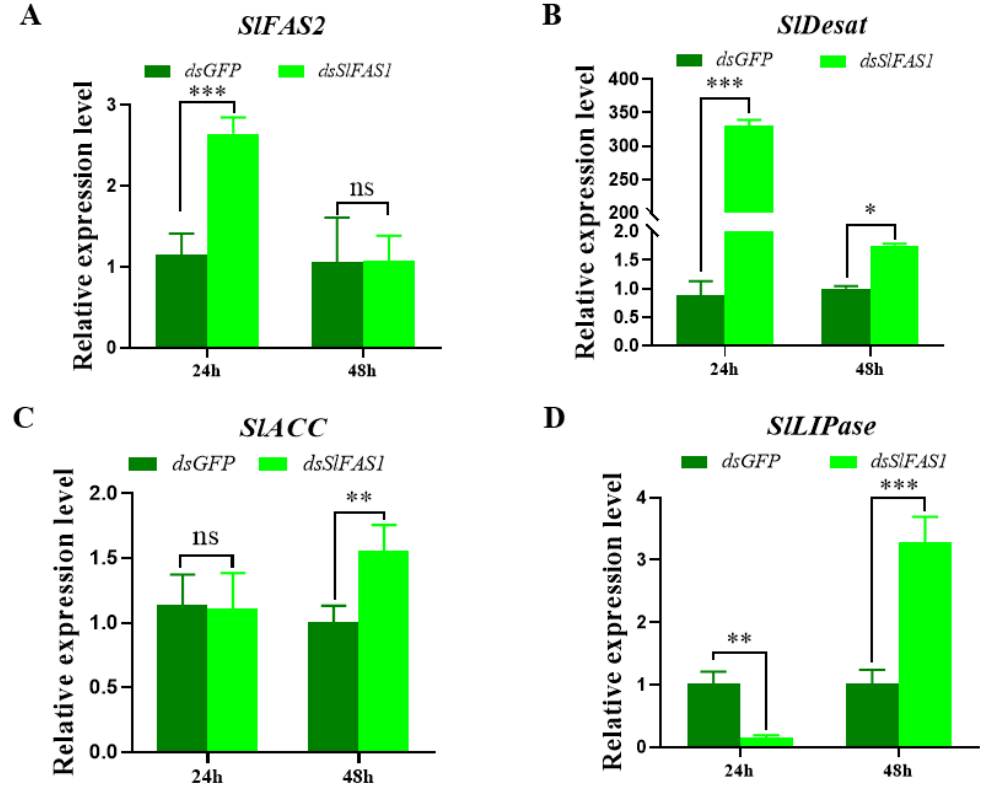
Figure 10. Effect of silencing SlFAS1 on the expression levels of other key genes in the lipid synthesis pathway in S. litura larvae. ( A ) SlFAS2 expression levels after dsSlFAS1 injection. ( B ) SlDesat expres- sion levels after dsSlFAS1 injection. ( C ) SlACC expression levels after dsSlFAS1 injection. ( D ) SlLIPase expression levels after dsSlFAS1 injection. One-way analysis of variance (ANOVA) with Tukey’s post hoc test was used to compare significant differences in the expression levels of each target gene. Significant differences were indicated by asterisks (* p < 0.05; ** p < 0.01; *** p < 0.001; ns, no signifi- cant differences).